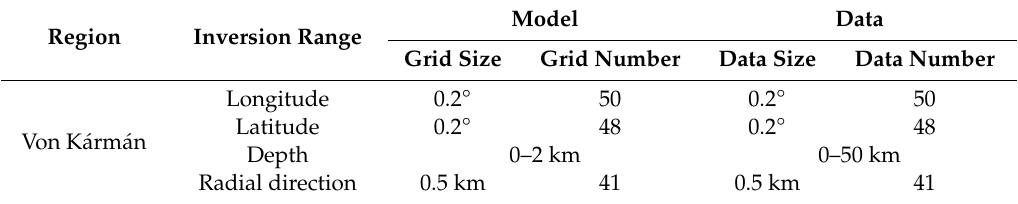
Table 1. The 3D mesh and dataset for